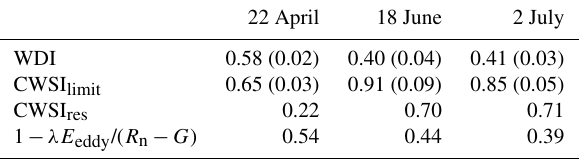
Table 4. Mean values and standard deviation (in parentheses) of WDI maps along with the measured stress index ( 1 − λE eddy /( R n − G)) and CWSI indices. CWSI res and CWSI limit are computed ac- cording to Jackson et al. (1981); Eqs. (10), (6) and (7),